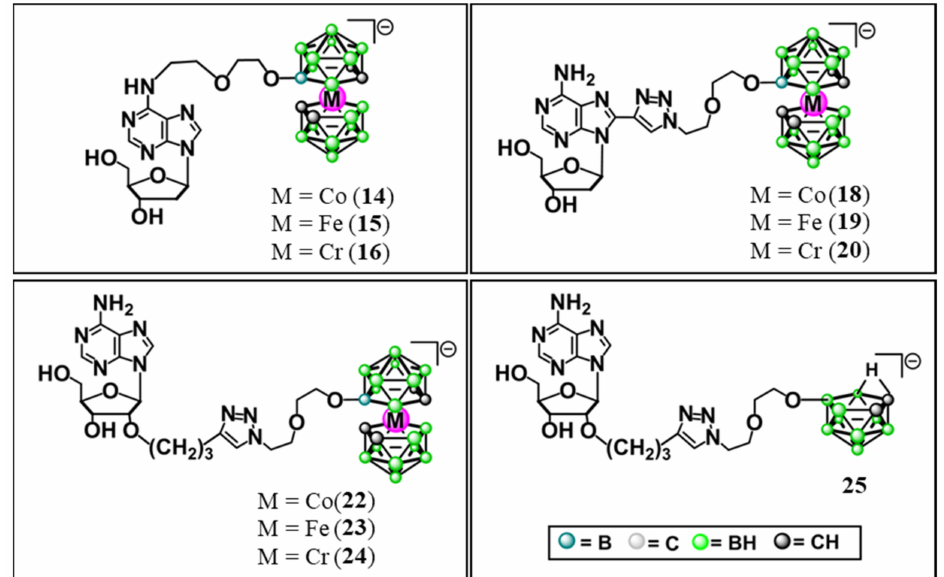
Scheme 1. Adenine nucleosides modified with metallacarboranes and nido -carborane; 6- N -{5- [3,3 (cid:48) -metalla-bis(1,2-dicarba- closo -undekaborate)-8-yl]-3-oxa-pentoxy}-2 (cid:48) -deoxyadenosine ( 14 , 15